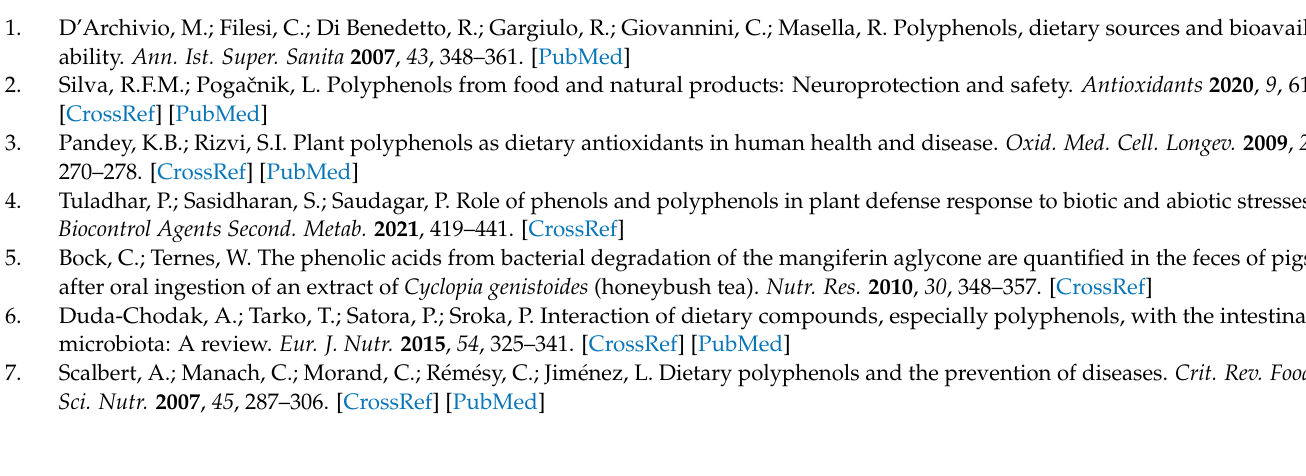
Figure S3: The 13C NMR spectra of 2-HPAA (a) and its alkali metal 2-hydroxyphenylacetates